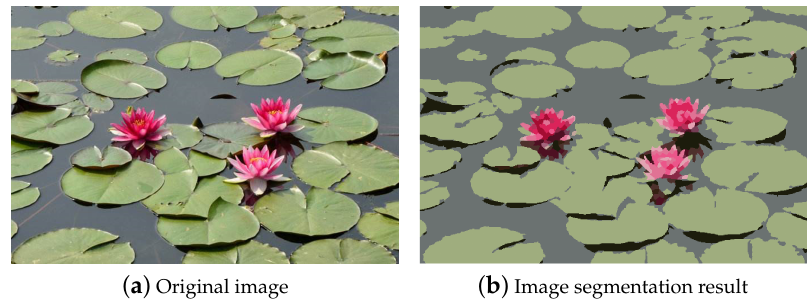
Figure 7. The segmentation result ( a ) by our method on the original picture ( b